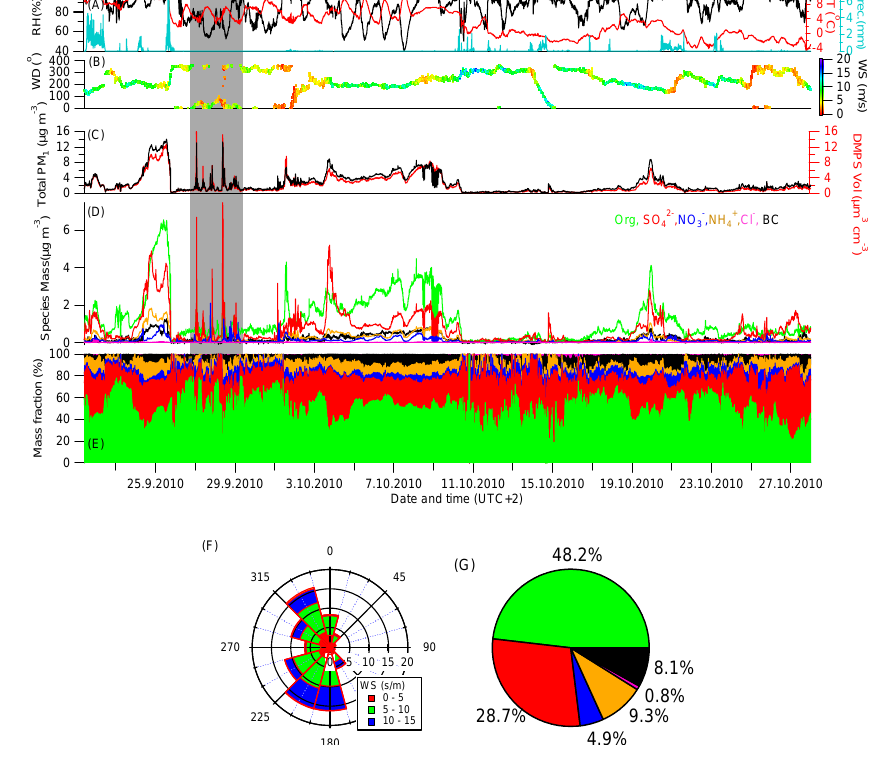
Figure 2. Meteorological measurements and mass characterizations of atmospheric PM 1 in this campaign. (a) Relative humidity, temperature and precipitation; (b) wind direction and speed; (c) comparison of total PM 1 mass to volume concentration from DMPS; (d) time series of chemical species, (e) the mass fractions; and (f) wind rose. The radial axis shows the wind probabilities in each direction (%). (g) Pie chart of chemical species. Color scheme in panels (e) and (g) is identical to (d) . The gray bar is chosen as an example of primary aerosol emission period (refer to Sect. 3.1).